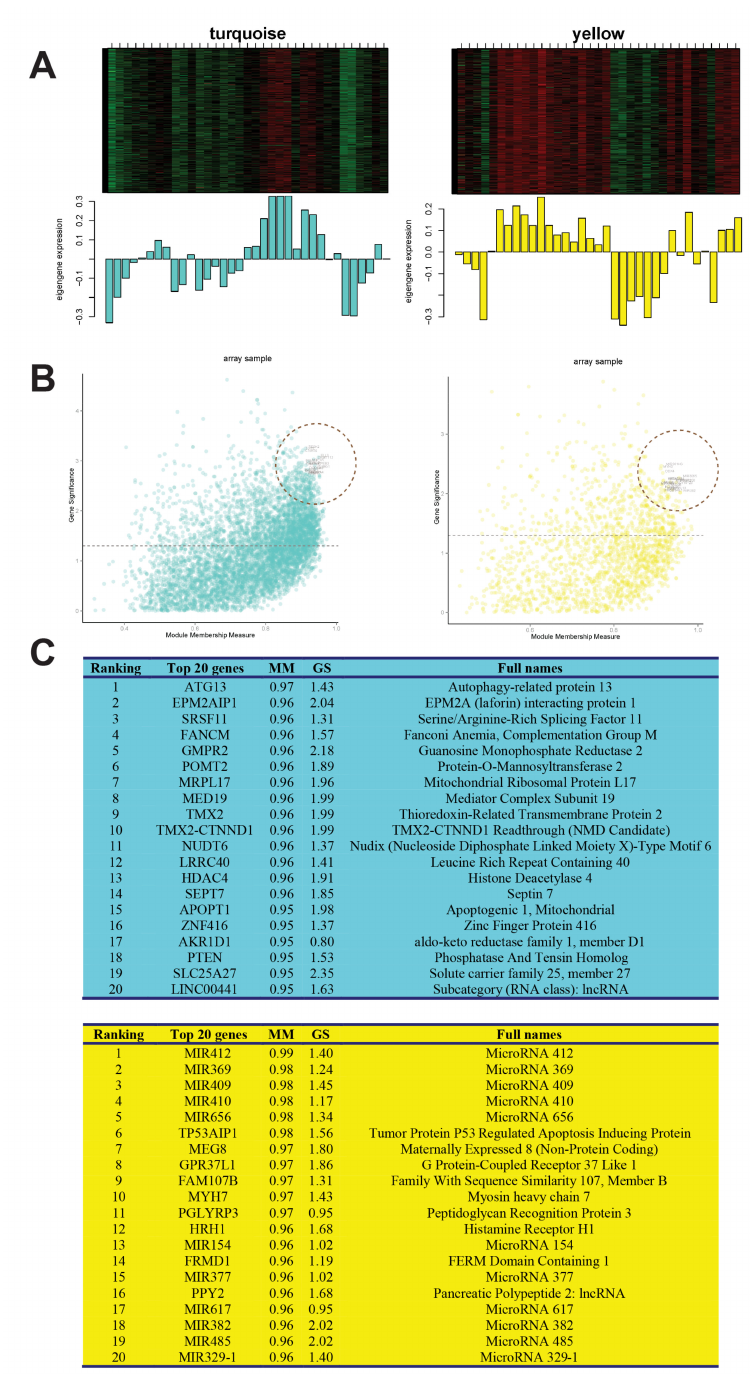
Figure 3. The hub genes in the turquoise and yellow modules. ( A ) The eigengene plots of turquoise and yellow modules. The top denotes the heatmaps of 35 samples, each row represents a promoter region, and each column represents a sample. The bottom denotes the bar plots of eigengene in each sample. The turquoise color represents the turquoise module, and the yellow color represents the yellow module. ( B ) The scatter plots of hub genes in turquoise and yellow modules. The x -axis represents the inner-modular connectivity, and the y -axis represents the gene significance. The dashed line points out the threshold ( p -value = 0.05). The top 20 hub genes with the highest inner- modular connectivity are marked. ( C ) The top 20 hub genes in the turquoise module and yellow module. The background color represents the different modules. MM: Membership Measurement; GS: Gene